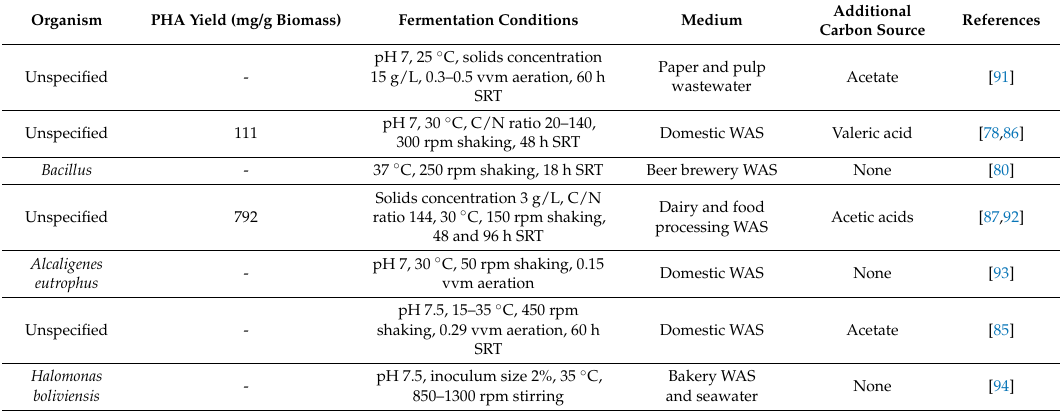
Table 5. Reported experimental (laboratory-scale) conditions for PHA production from WAS-derived media.